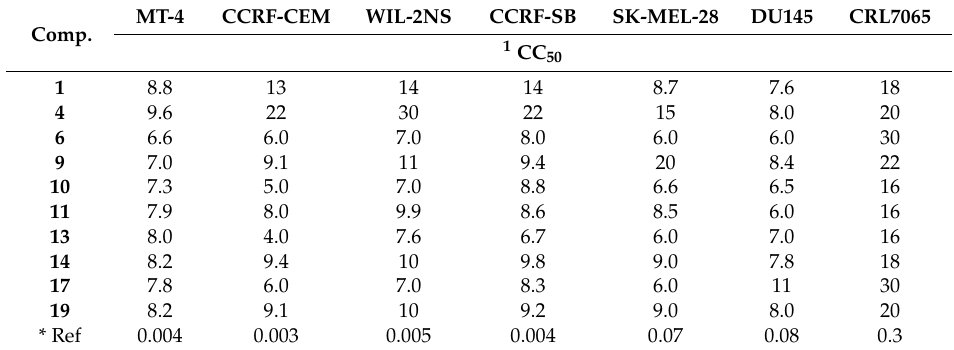
Table 4. Antiproliferative activity of selected compounds against human leukaemia/lymphoma, solid tumor and normal cell lines.